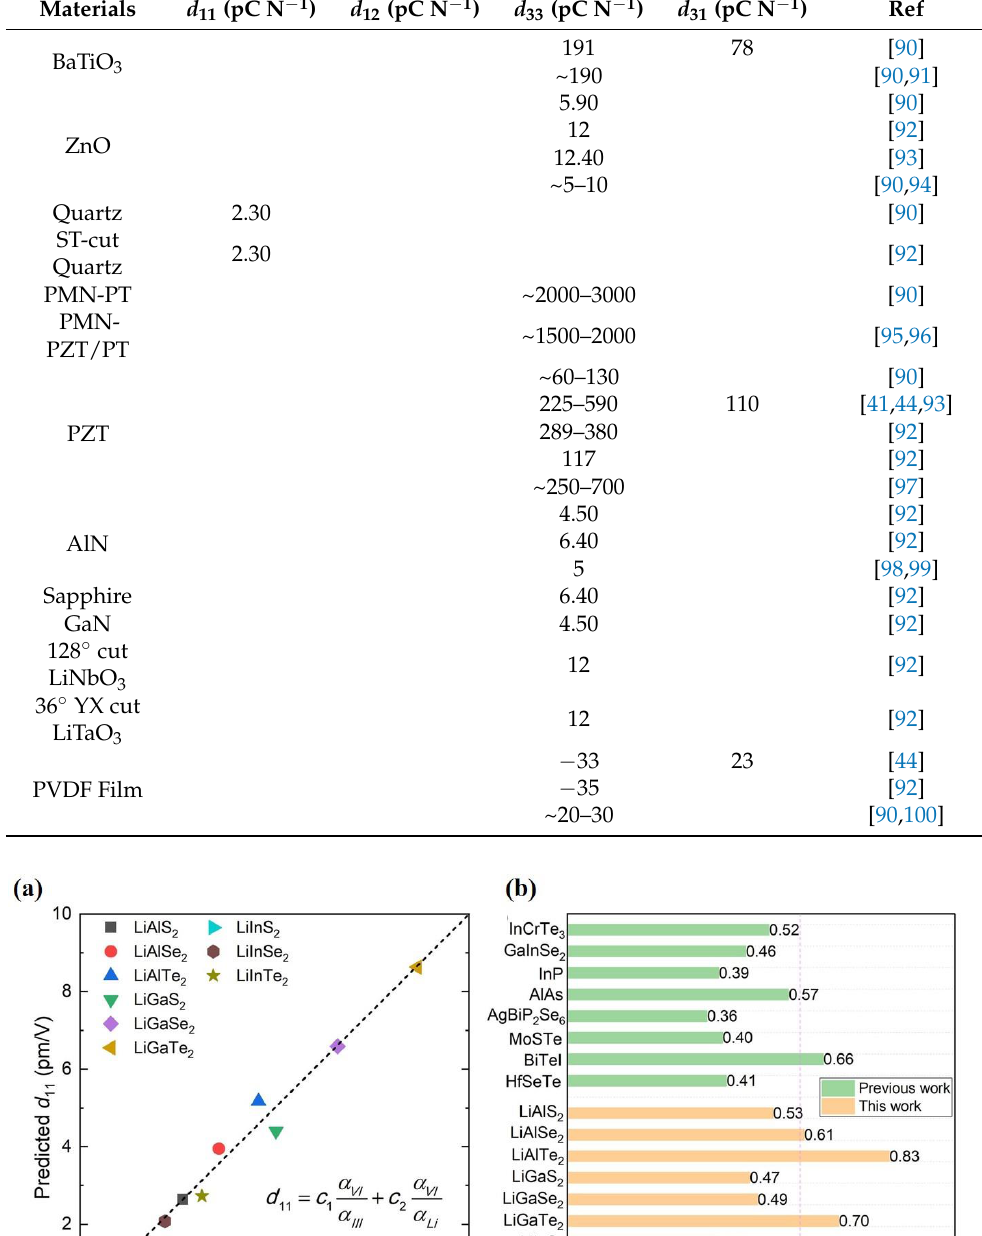
Table 3. Piezoelectric coefficient of common piezoelectric materials (pC N − 1 ).